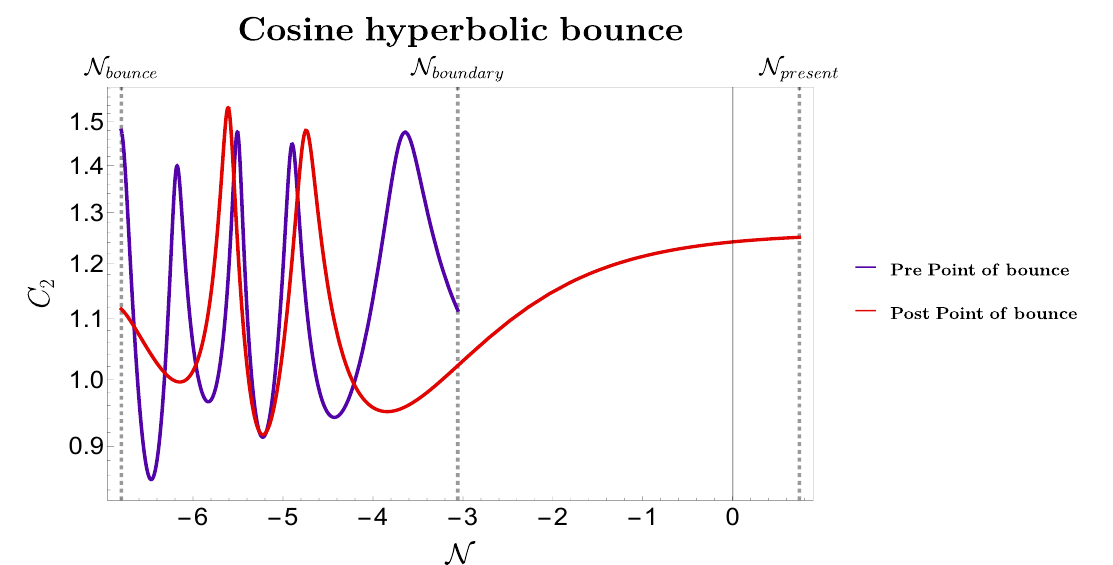
Figure 20: Variation of geodesically weighted complexity inside bouncing region with respect to number of e-foldings.